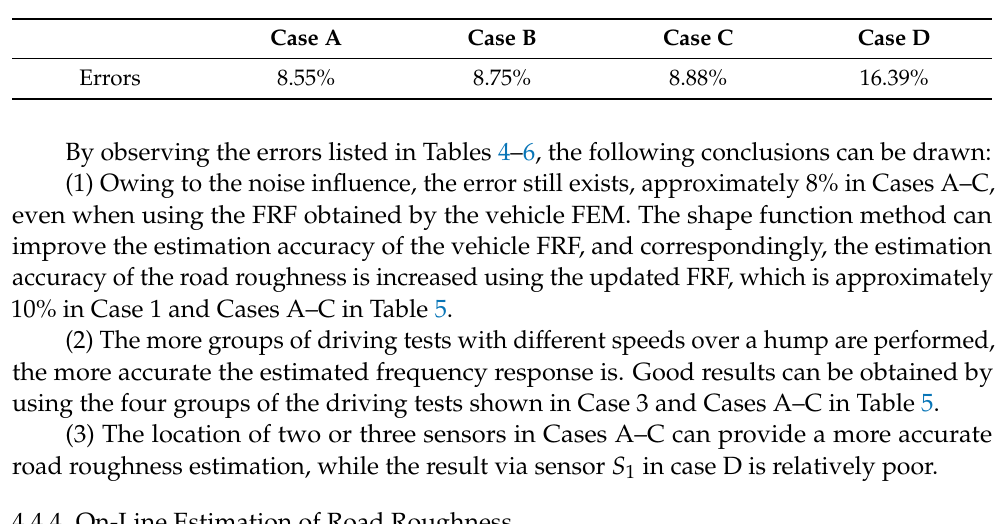
Table 6. Errors of the estimated road roughness using the FRF of the